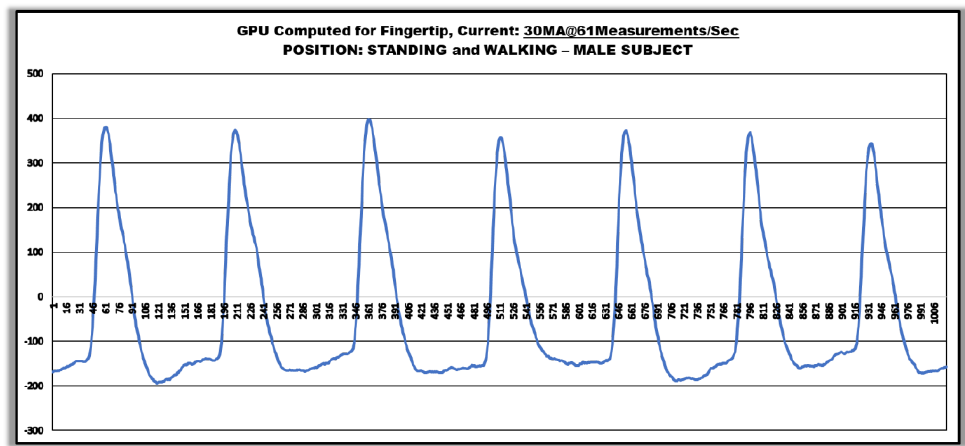
Figure 12. GPU-Computed Data using Fingertip: Observation Set D.